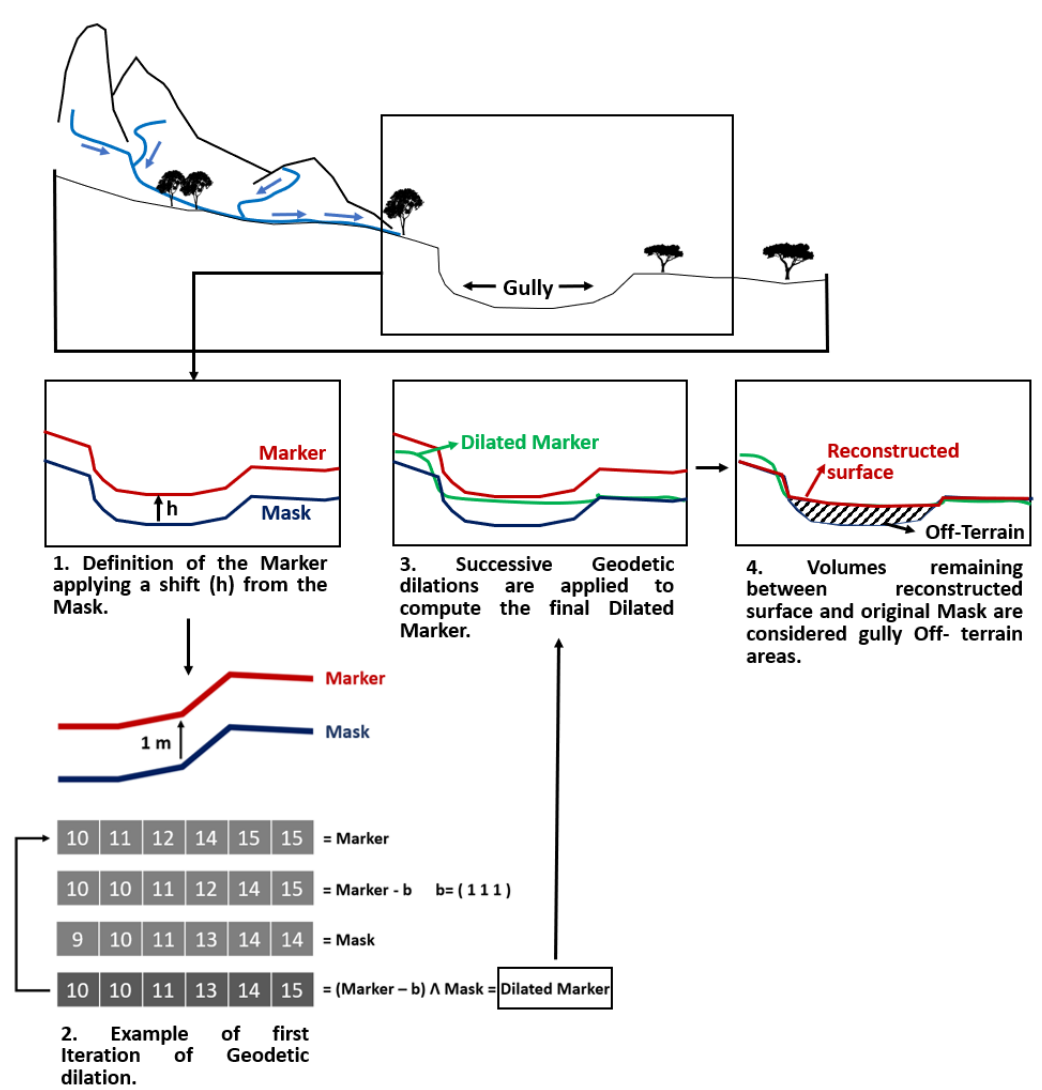
Figure 2. Simplified schema of the di ff erent steps involved in Inverted Morphological Reconstruction (IMR) applied on gully detection.